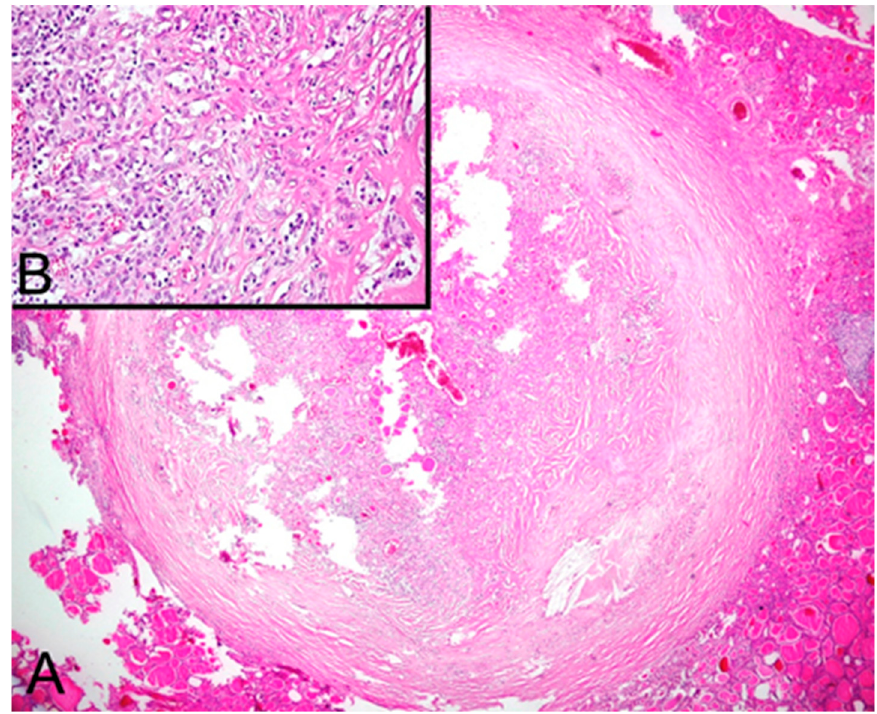
Figure 5. ( A ) HE stain showing a sclerosing-variant papillary thyroid carcinoma as a well-defined nodular mass (×40). ( B ) HE high power field image of tumor cells within the mass (×400).